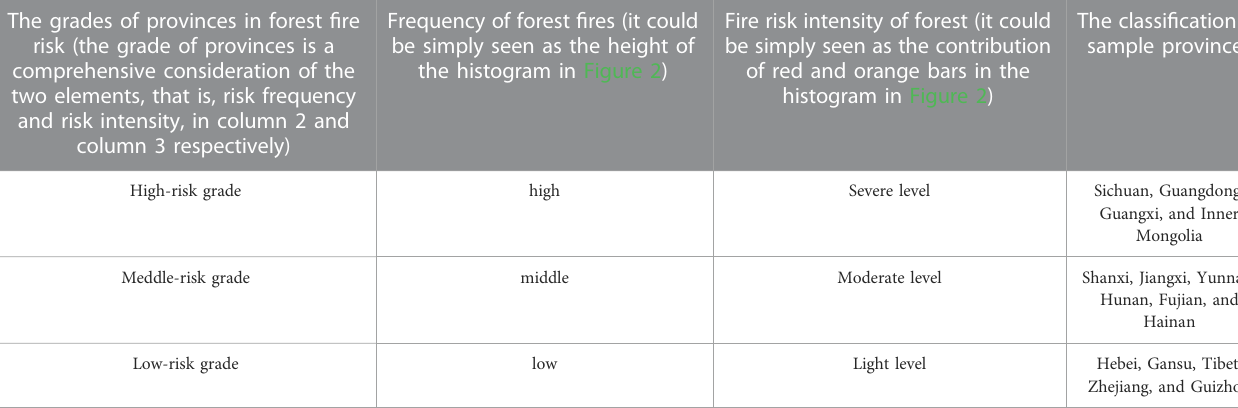
Fire risk intensity of forest (it could be simply seen as the contribution of red and orange bars in the histogram in Figure 2)